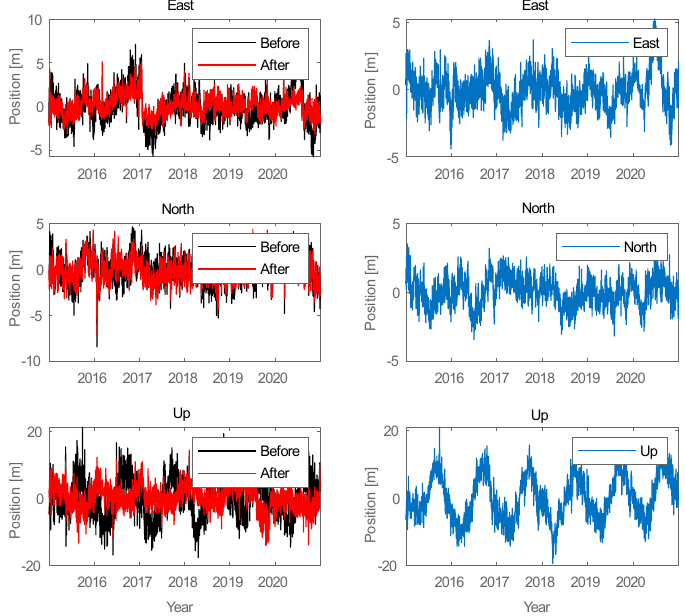
Figure 11. Signal processing in the GPS receiver working on the L1 frequency; on the left side, the signal waveform in color without the noise suppression system applied; on the right side, the working system operating in the LTE system signal elimination for the reception of signals from five satellites.